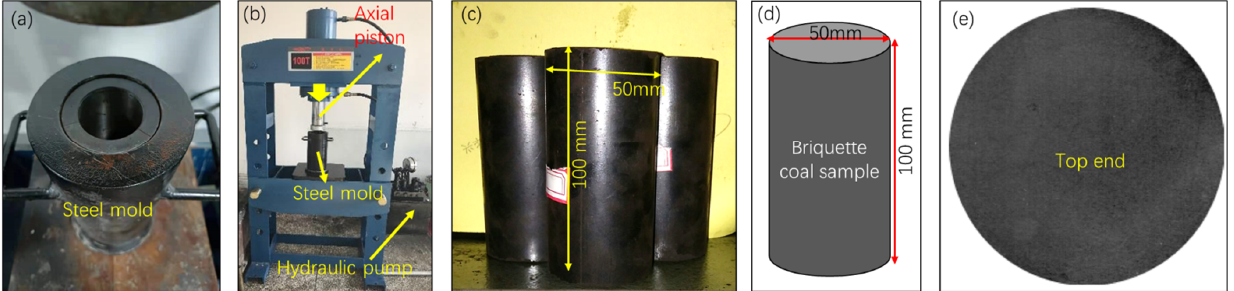
Figure 4. Loading setups for remodeling. ( a ) Steel mold; ( b ) compression machine; ( c ) briquette coal samples; ( d ) schematic of briquette coal sample; ( e ) top end of briquette coal sample. Table 2. The physical parameters of the briquette coal samples.